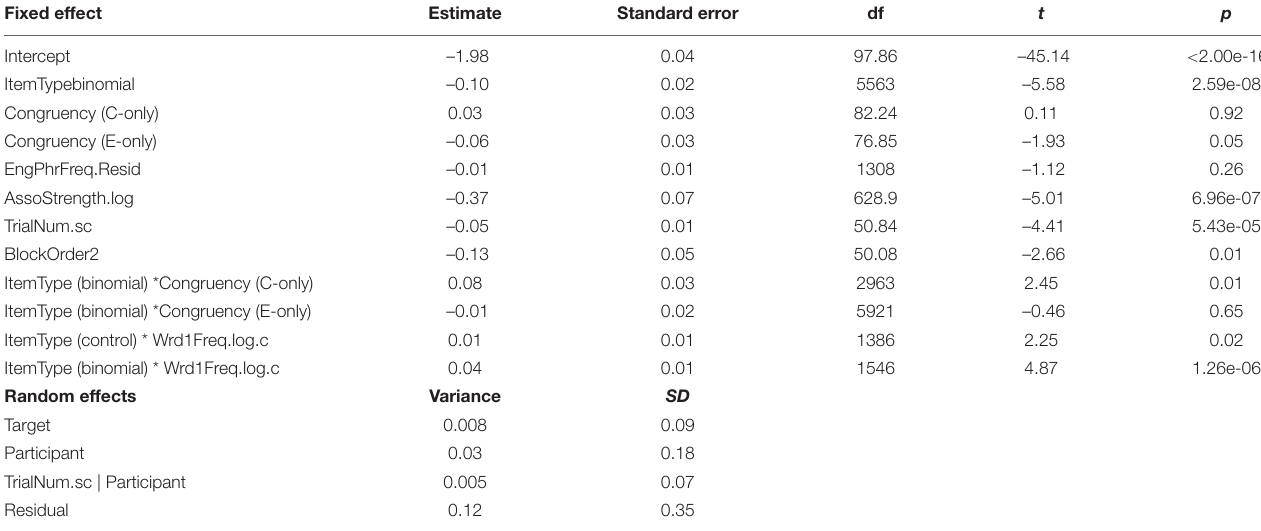
TABLE 5 | Results of mixed model for English monolinguals.